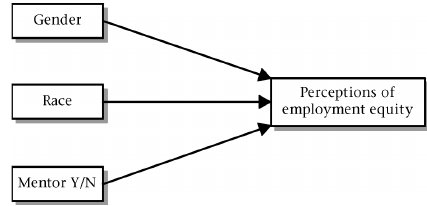
Figure 12: Biographical variables as predictors of the perceptions of employment equity